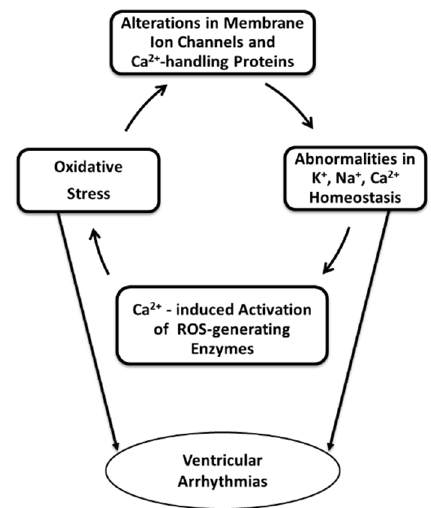
Figure 1. Stress‐promoted alterations in ion homeostasis of cardiac cells inducing a further production of reactive oxygen species, thereby highlighting the probability of ventricular arrhythmias as a result of such viscous cycle.